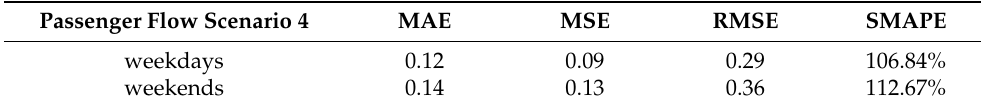
Table 12. The metrics of forecasting results for hub to suburban OD